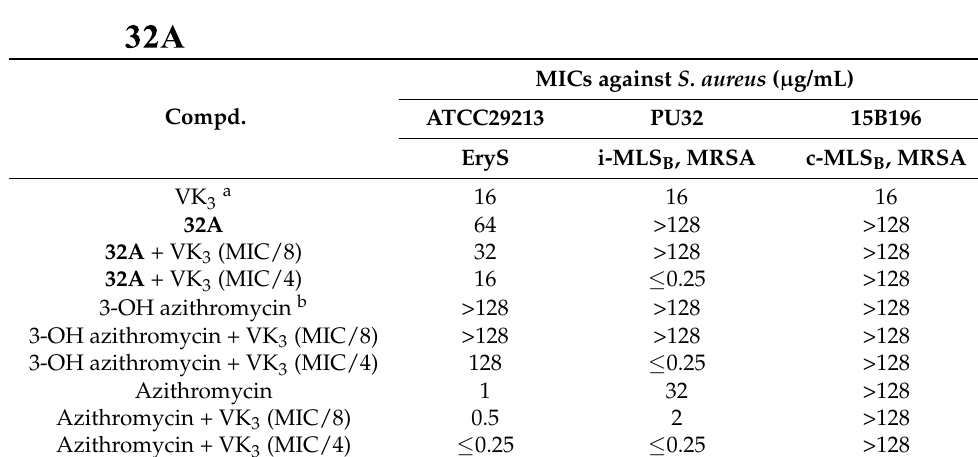
Table 3. In vitro antibacterial activity of 32A alone or in combination with menadione against S.